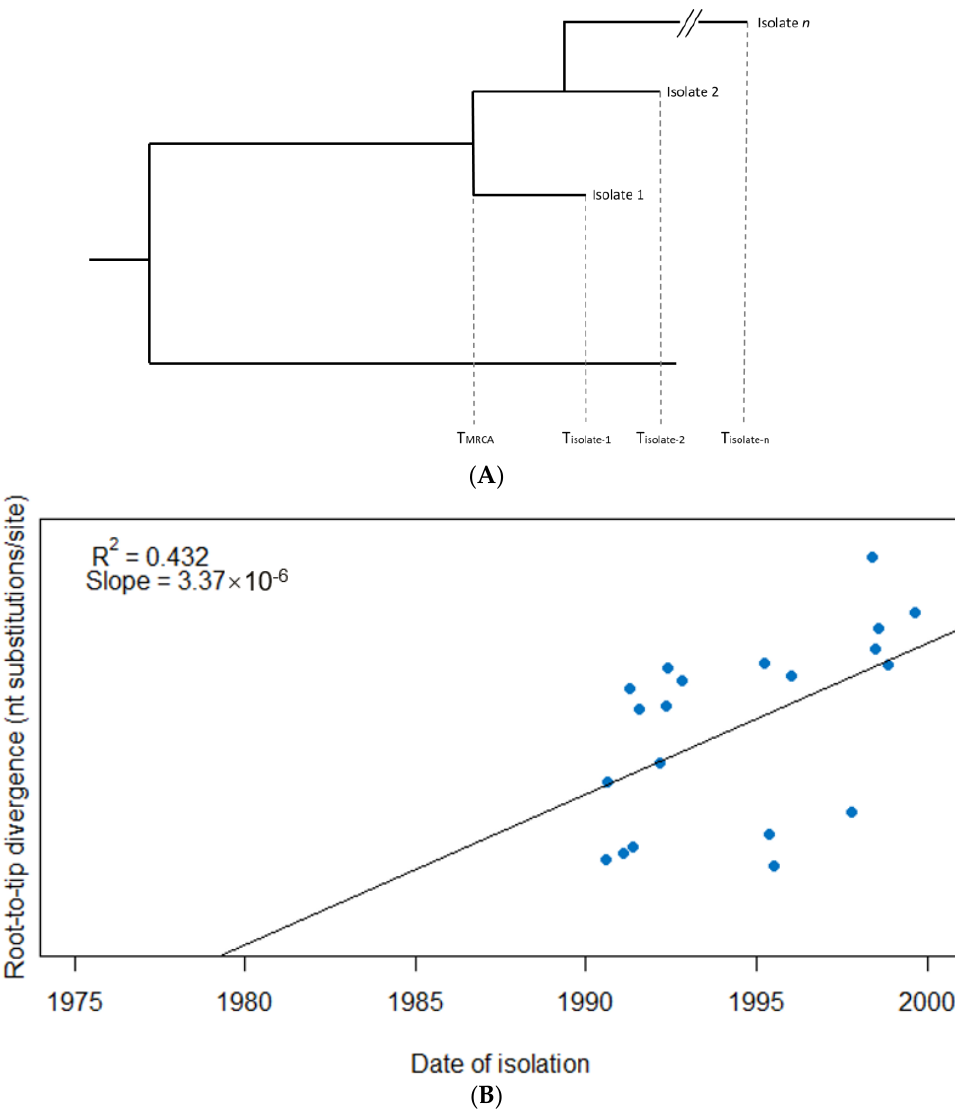
Figure 1. Root-to-tip regression analysis to detect evidence of a temporal signal among 20 hypo- thetical isolates. ( A ) A phylogenetic tree from which the root-to-tip distance for each isolate is calculated, i.e., the evolutionary change between the time to most recent common ancestor of the sample (TMRCA) and the sampling time of each respective isolate (T isolate-1 , T isolate-2 , T isolate-n ), usually measured as the number of nucleotide substitutions per site over the respective time period. ( B ) The isolates are plotted based on their date of isolation (x-axis) and root-to-tip divergence, i.e., the number of nucleotide substitutions per site (y-axis). The linear regression provides a measure of temporal signal (R 2 ) as well as molecular clock rate assuming a strict clock is to be applied (slope). In this example, an R 2 of 0.432 suggests evidence of a temporal signal in the data, while the (strict) molecular clock rate is estimated at 3.37 × 10 − 6